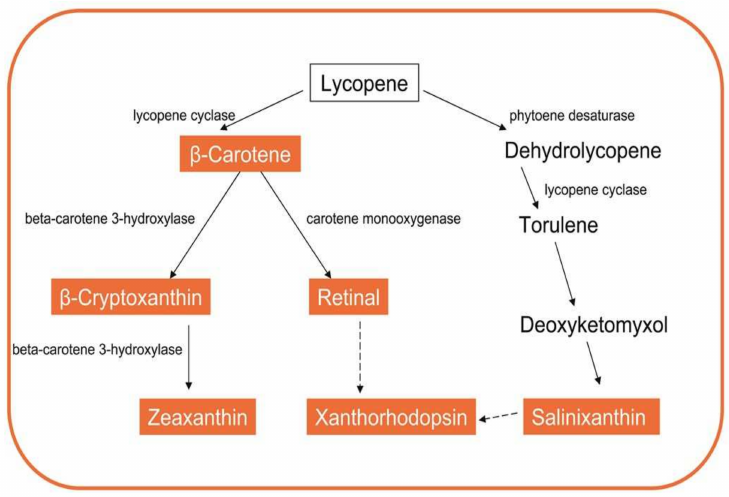
Figure 2. Metabolic pathways for the synthesis of representative biomolecules carotenoids.